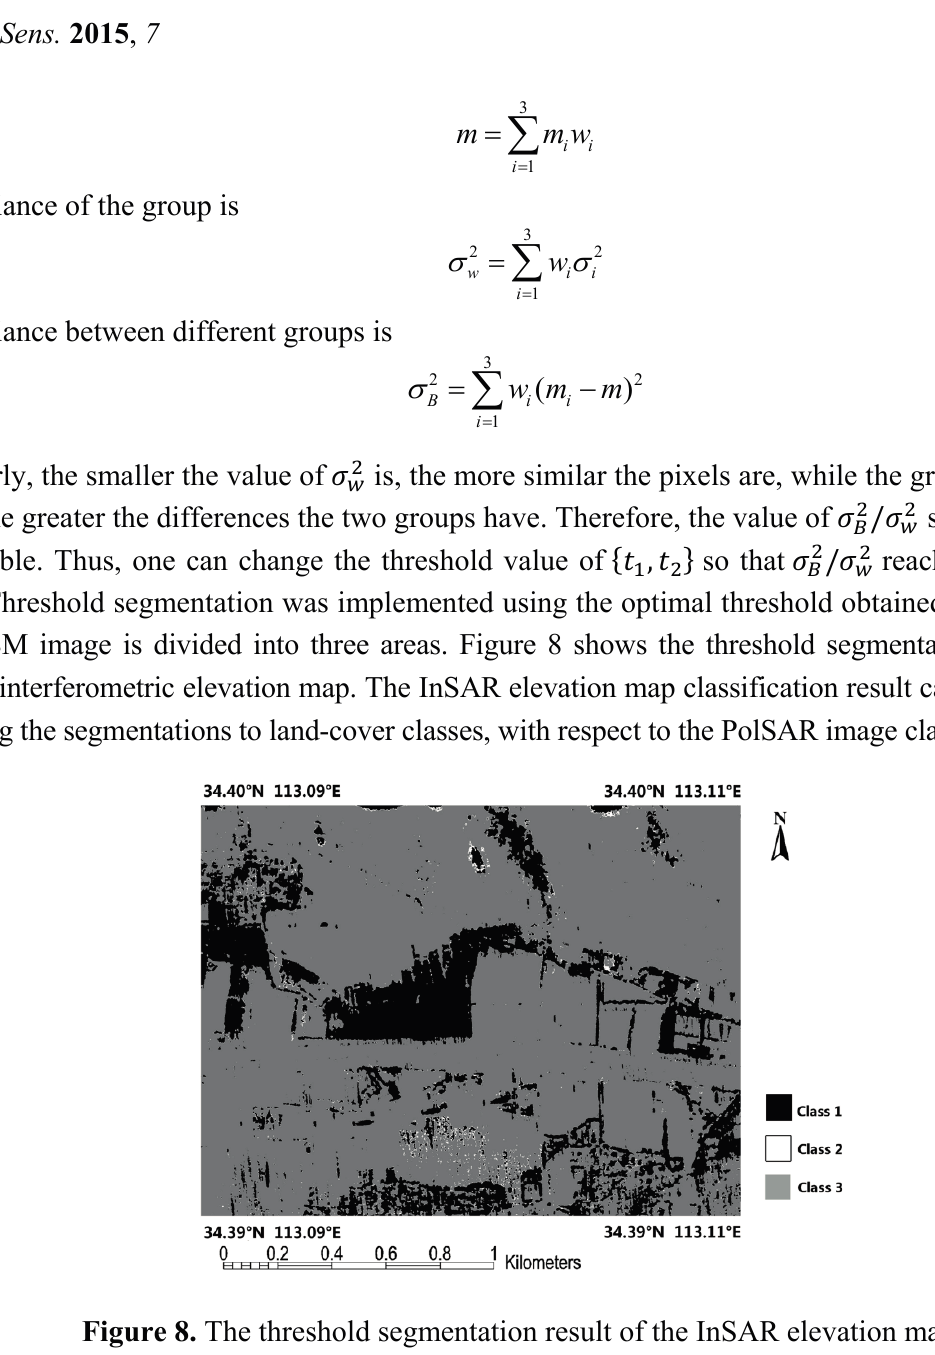
Figure 8. The threshold segmentation result of the InSAR elevation